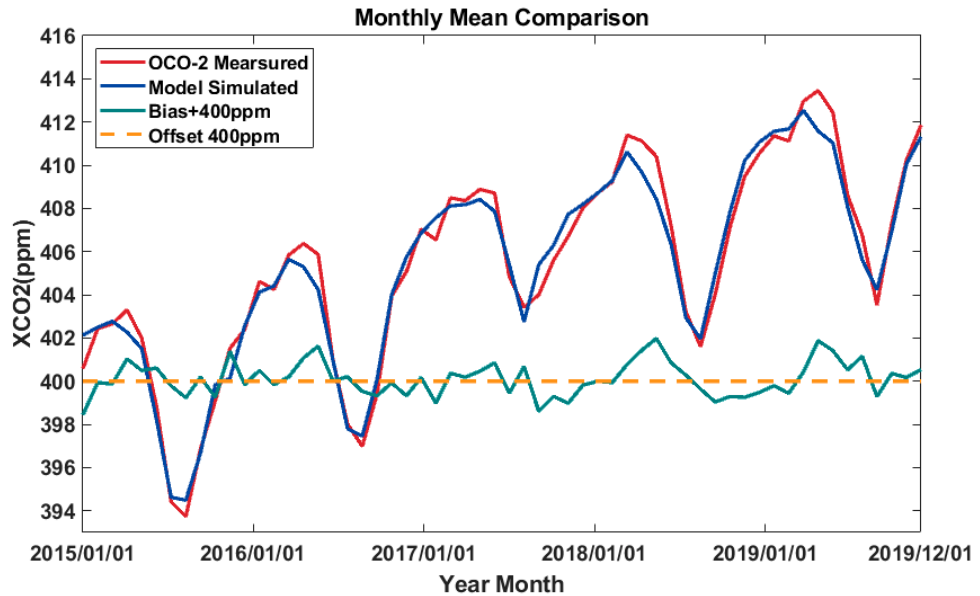
Figure 9. Comparison between monthly XCO 2 concentrations from the OCO-2 satellite (red line) and the random forest model (blue line), as well as the deviation value (green line), where the deviation value increased by 400 ppm (yellow dotted line).